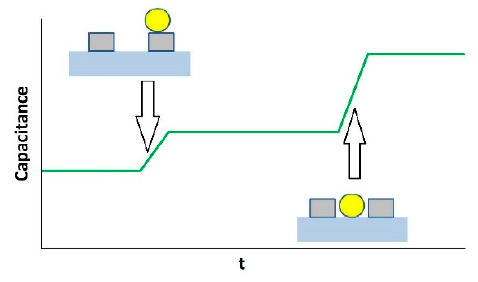
Figure 1. Detection principle of the capacitive sensor. The grey rectangles indicate micro-electrodes on top of the blue SiO 2 . Yellow spheres indicate particles deposited on top of the electrodes, which then cause the capacitance to change abruptly.